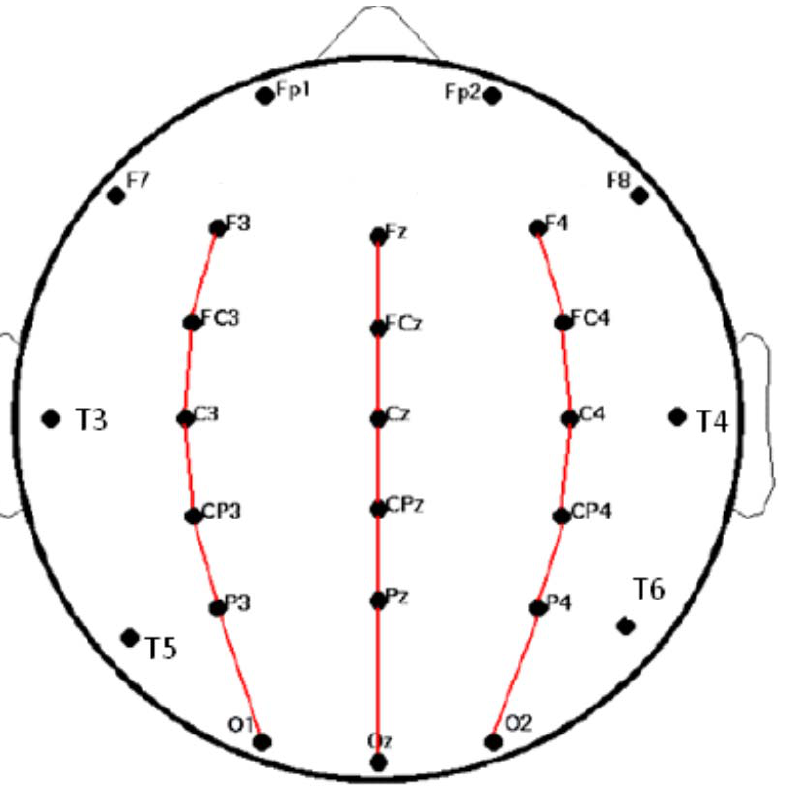
Figure 1. Schematic view of the electrodes placed in accordance with the 10–20 International Systems showing the 26 electrodes. The three chains approximately parallel to the midline are the chains along which we did our traveling wave analysis.